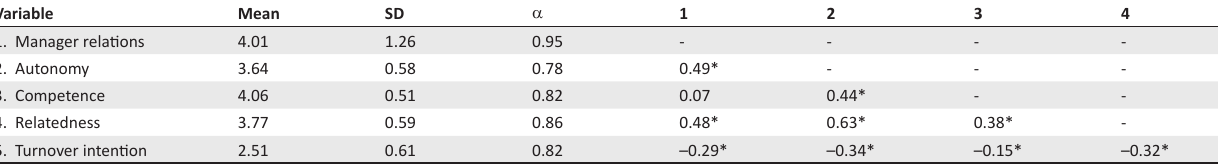
TABLE 3: Descriptive statistics, alpha coefficients and correlations of the scales ( N = 507).